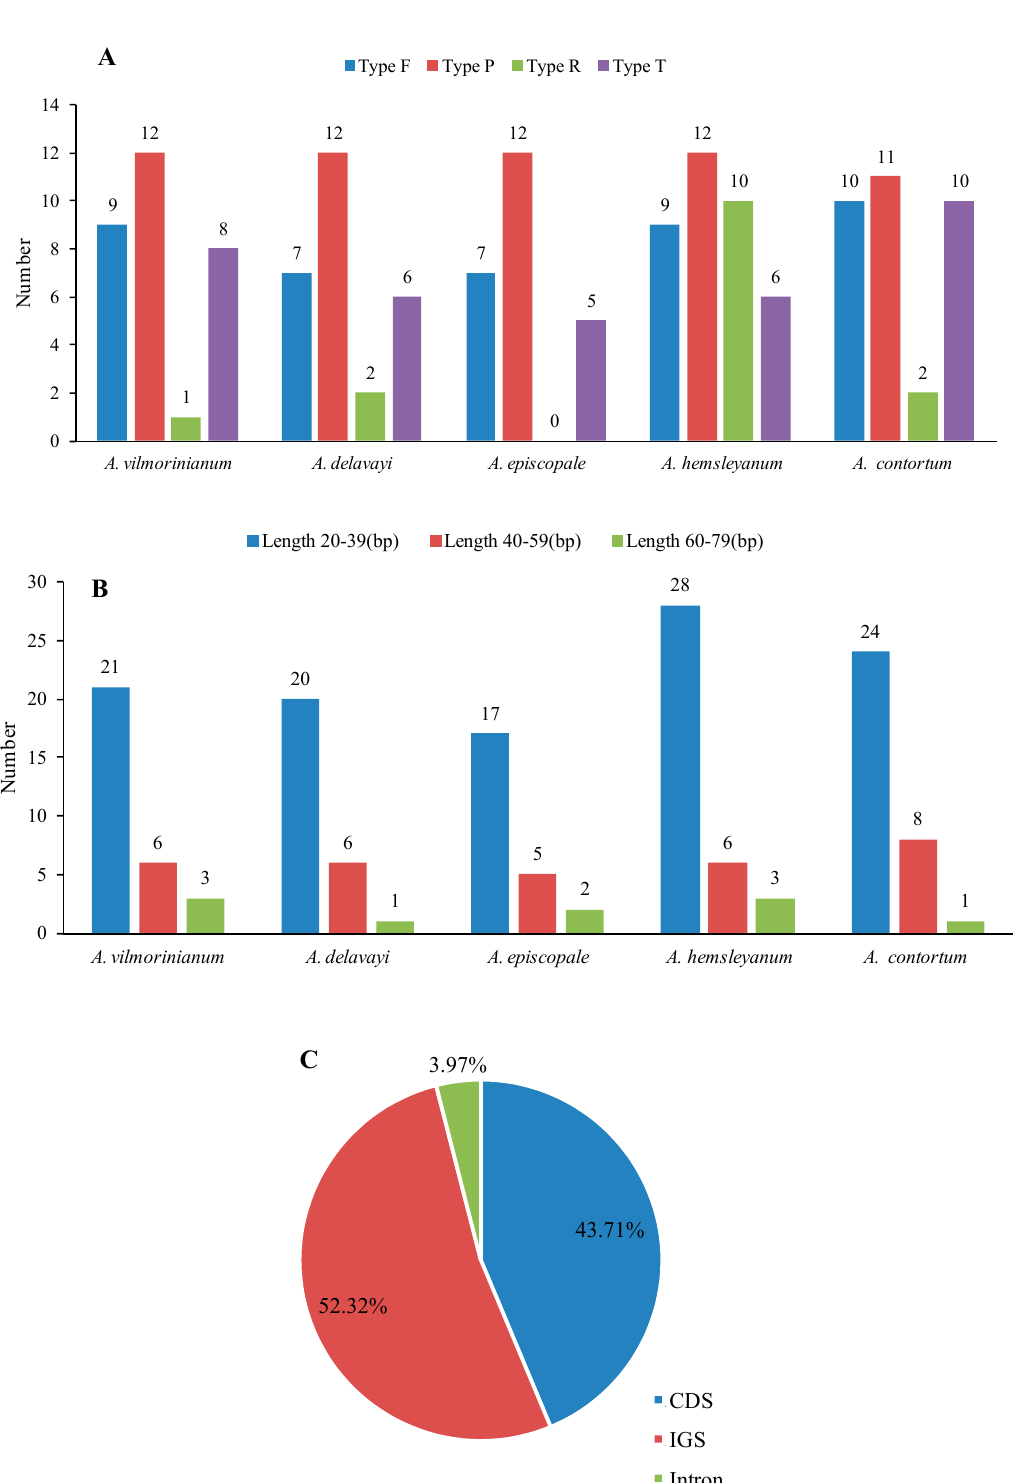
Figure 3. The type, length and distribution of repeats in the chloroplast genomes of five Aconitum species. ( A ) Number of different repeat types: F, forward; P, palindromic; R, reverse; T, tandem; ( B ) Number of different repeat lengths; ( C ) Proportion of repeats in LSC, SSC and IR regions.